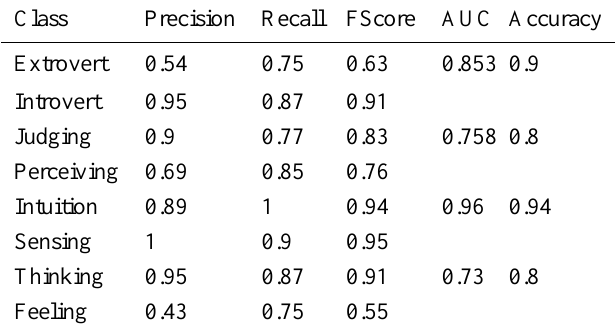
K-Nearest neighbour result with feature selection